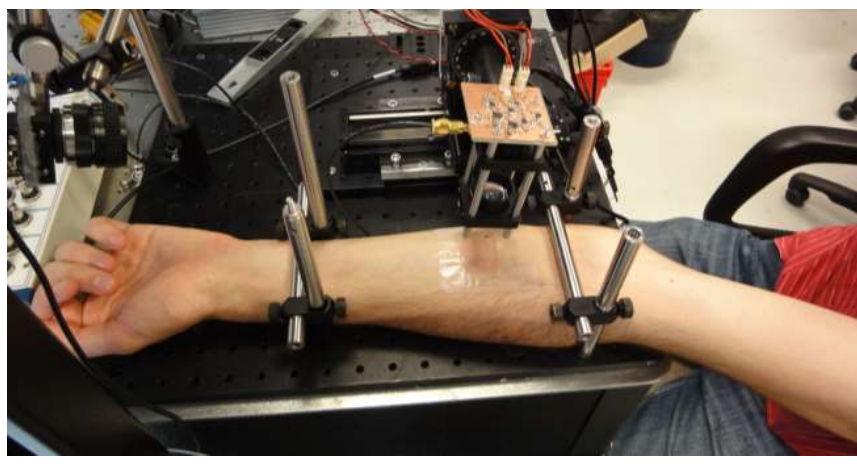
Figure 19. Patient